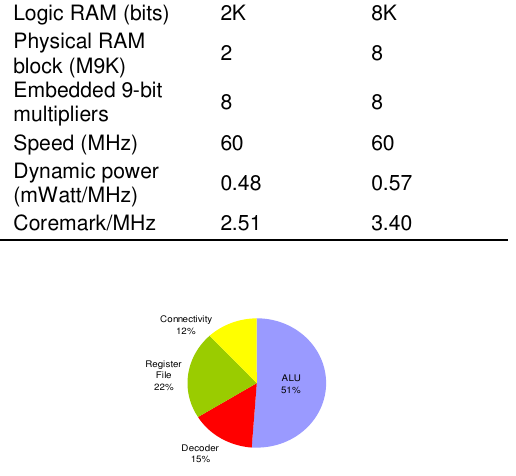
Figure 17. Percentage of processor logic cells per module for dual issue processor.